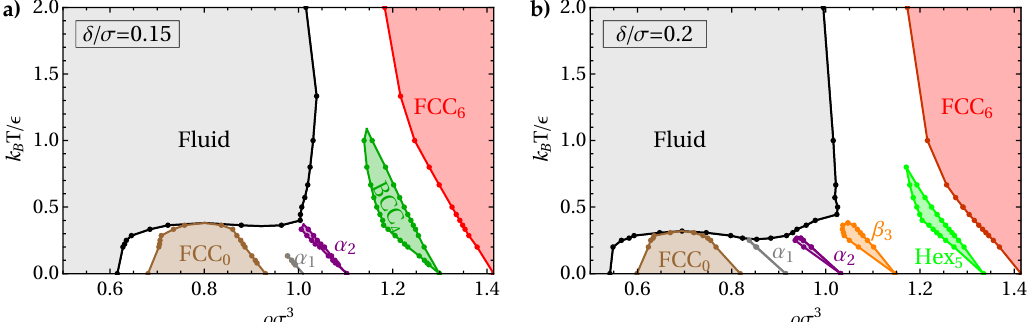
Figure 5. Phase diagrams for interaction ranges δ / σ = 0.15 ( a ) and 0.2 ( b ), as a function of density ρ and temperature T . The white areas indicate coexistence regions. All tie lines between coexisting state points are horizontal. Coexistences (points) are obtained from free energies calculated using cell theory. Lines are guides to the eye only. Triple points are obtained by extrapolating coexistence